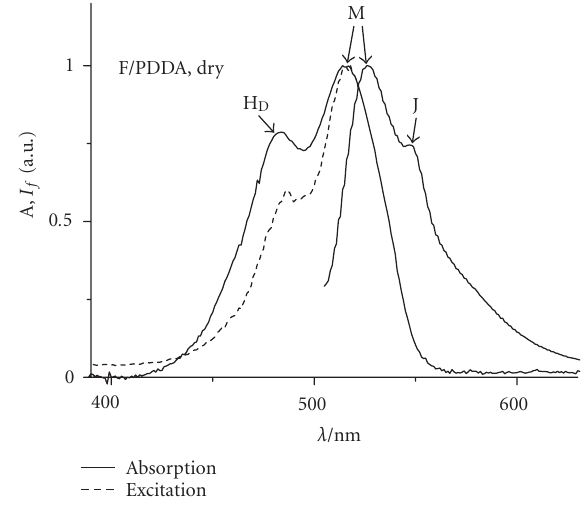
Figure 6: Absorption (solid), excitation (dashed, λ em = 530nm) and emission ( λ exc = 500nm) spectra of a dry F/PDDA ESAM; 1 bilayer per side of the quartz